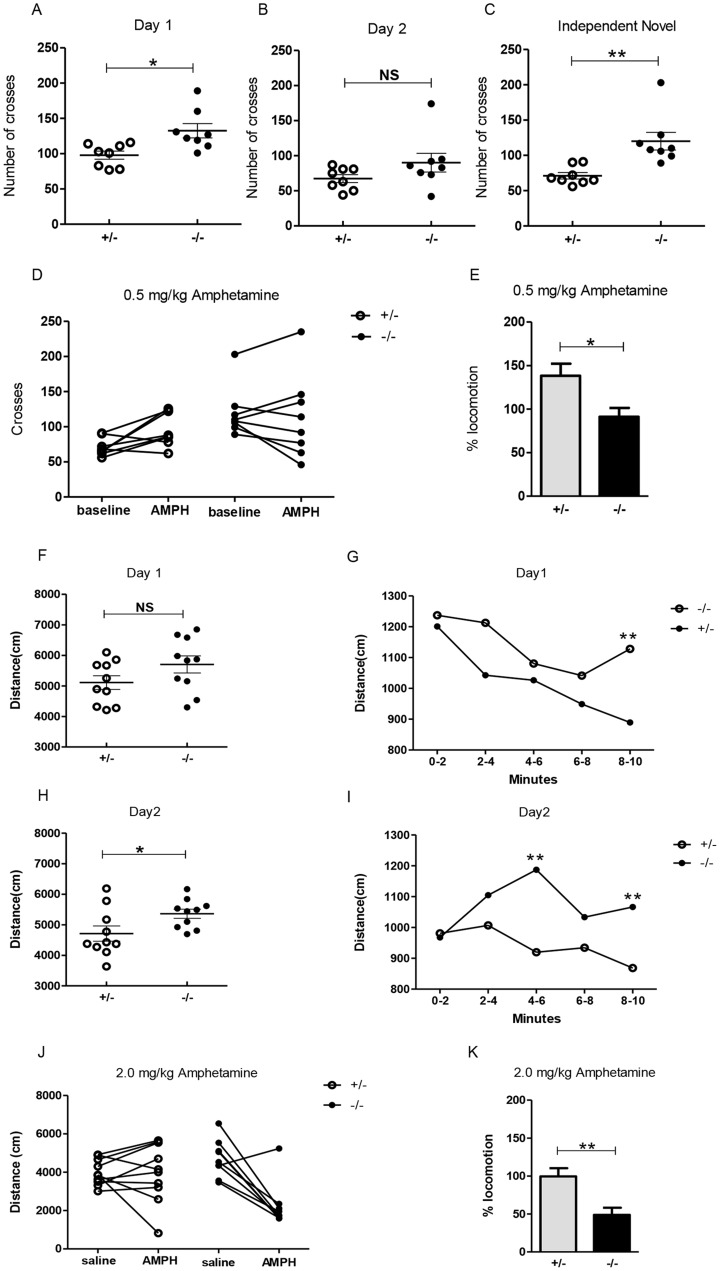
Hyperlocomotion of Elfn1−/− mice.(A–E) Experiment 1. (A) The number of crosses on day 1 of open field testing was significantly higher for Elfn1−/− mice than in Elfn1+/− mice (p = 0.01; n = 8/genotype). (B) On day 2, in the same open field, there was no significant difference between the groups (p = 0.138) but the mean number of crosses remained higher for Elfn1−/− mice (90.13±13.32) versus Elfn1+/− mice (67.38±5.62; n = 8/genotype). (C) Introduction to a novel environment again confirmed a higher number of crosses in Elfn1−/− mice versus Elfn1+/− mice (p = 0.0025; n = 8/genotype). (D) Graph shows the number of crosses before and after 0.5 mg/kg AMPH for each mouse in experiment 1 (n = 8/genotype). Elfn1+/− (white circles), Elfn1−/− (black circles). (E) The mean percentage distance travelled by Elfn1+/− and Elfn1−/− mice after 0.5 mg/kg. Student's t test p value = 0.0159. (F–K) Experiment 2. (F) On day 1, statistical analysis revealed no significant difference between the groups however, the mean distance travelled by Elfn1−/− mice was greater than by Elfn1+/− mice (5701±278.8 for Elfn1−/− and 5108±222.4 for Elfn1+/−, n = 10/genotype; p = 0.1141). (H) On day 2, in the same open field, Elfn1−/− mice travelled a significantly greater distance than Elfn1+/− mice (p = 0.0381; n = 10/genotype). (G) On day 1, the mean distance travelled by Elfn1−/− mice remained higher than for Elfn1+/− mice over the 10 minutes, and a significant difference between the genotypes is evident in the final 2 minute bin (p = 0.0021; n = 10/genotype). (I) On day 2, a significant difference between groups in the mean distance travelled is identified at the 4–6 minute and 8–10 minute time bins (p = 0.0024 and p = 0.0067 respectively). All data expressed as means, and Student's t test used to analyse statistical difference betwen the groups. Post-hoc analysis is not corrected for multiple testing. (J) Graph depicts differences in distance travelled by each mouse when administered saline and 2.0 mg/kg AMPH in experiment 2 (n = 10 Elfn1+/−, n = 9 Elfn1−/−). (K) The mean percentage distance travelled by Elfn1+/− and Elfn1−/− mice after 2.0 mg/kg of AMPH. Student's t test p value = 0.0029 for 2.0 mg/kg.